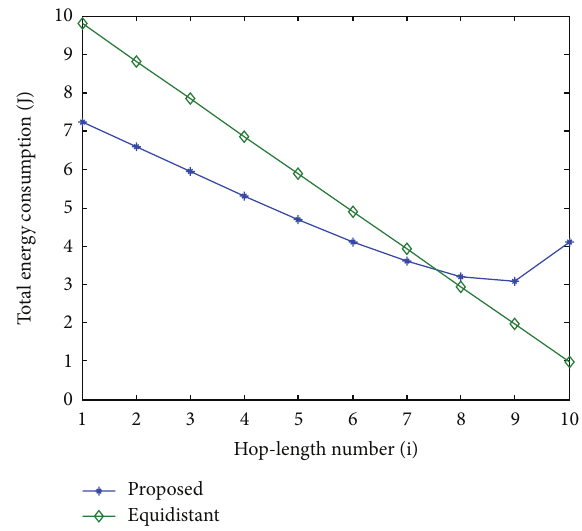
Figure 16: Total energy consumption for each cluster, 4 bits trans-